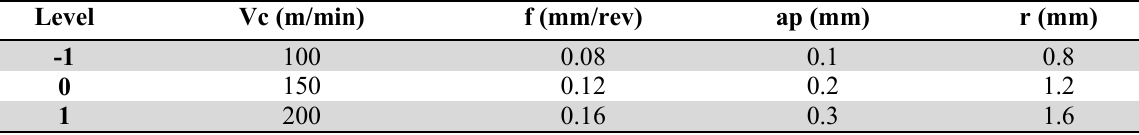
Assignment for the levels to the factors